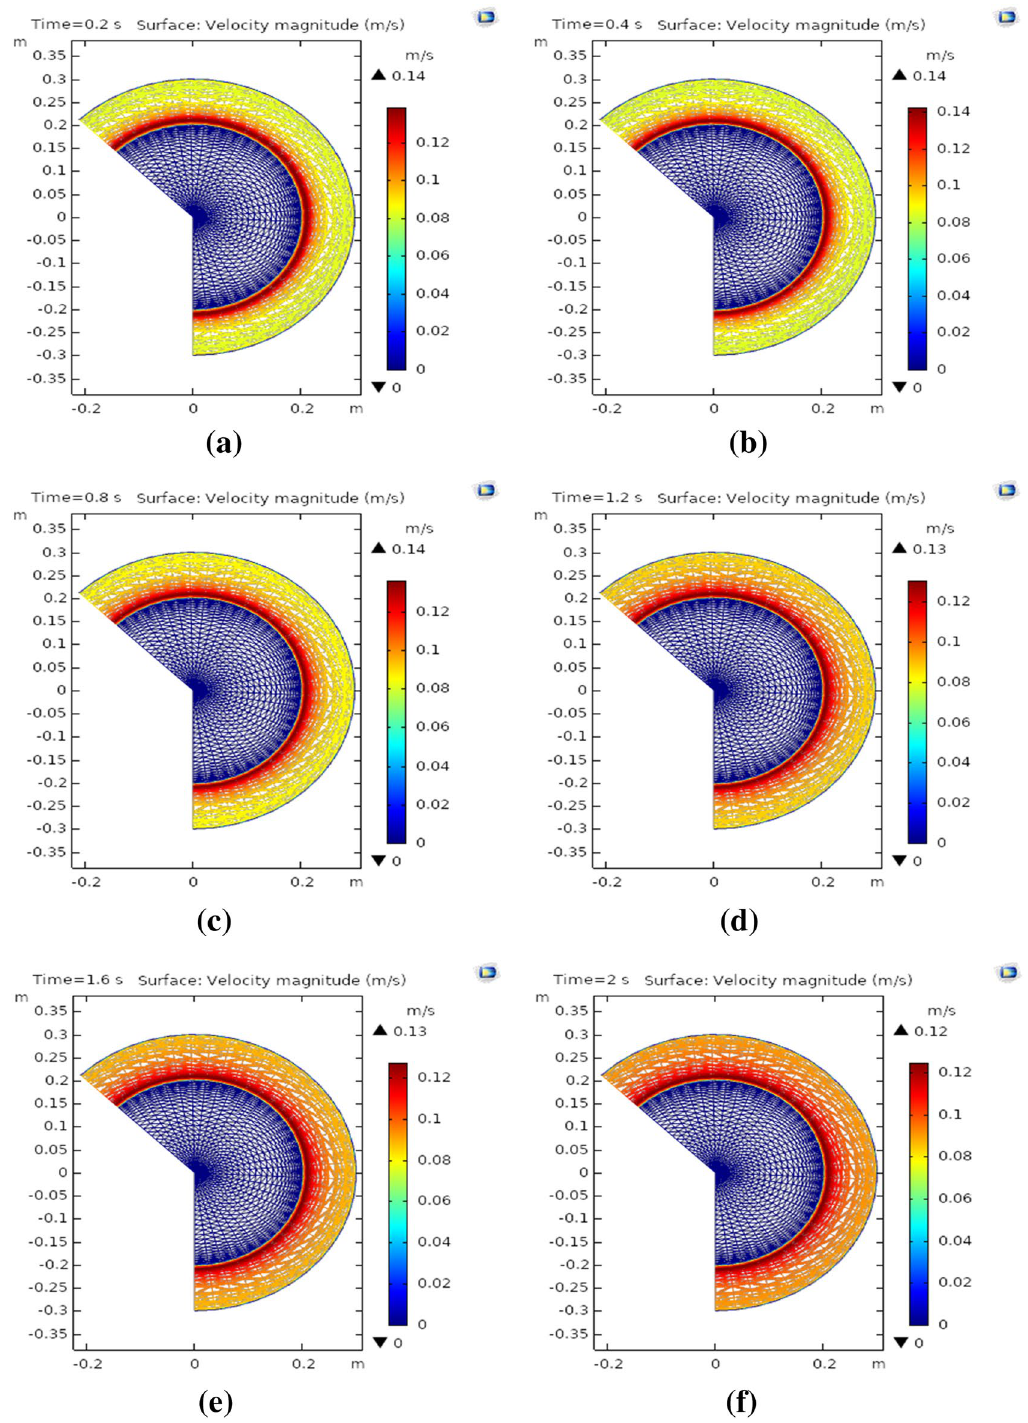
Figure 7. (a) Velocity magnitude of the disk at 0.2 s, (b) velocity magnitude of the disk at 0.4 s, (c) velocity magnitude of the disk at 0.8 s, (d) velocity magnitude of the disk at 1.2 s, (e) velocity magnitude of the disk at 1.6 s, (f) velocity magnitude of the disk at 2 Discrete upper surface velocity magnitude. The change in surface velocity magnitude at the upper surface of the rotating disk is presented in Fig. 7a–f at respective times. These upper surface plots also disclose the detailed change in velocity magnitude with a variation of the time step. Figure 7a, b showed that the maxi- mum surface magnitude at the upper surface of the disk is 0.14 m/s at times 0.2 s and 0.4 s, respectively. It is also worth noting here that the change in surface magnitude is visible. The blue region indicates minimal velocity, the green region denotes moderate surface magnitude and the red zone demonstrates maximal surface velocity